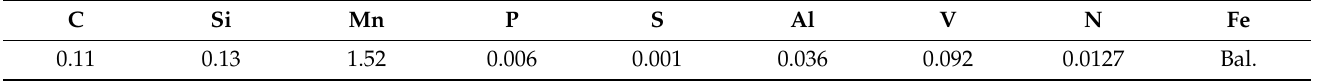
Table 1. Chemical compositions of experimental steel